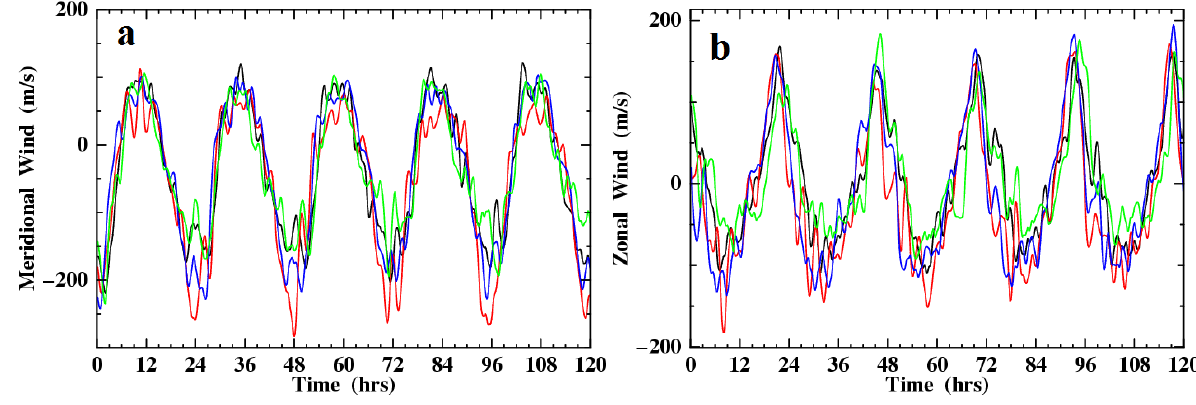
Fig. 5. Same as Fig. 4 except for (a) meridional wind and (b) zonal wind. The positive values indicate northward and eastward winds.